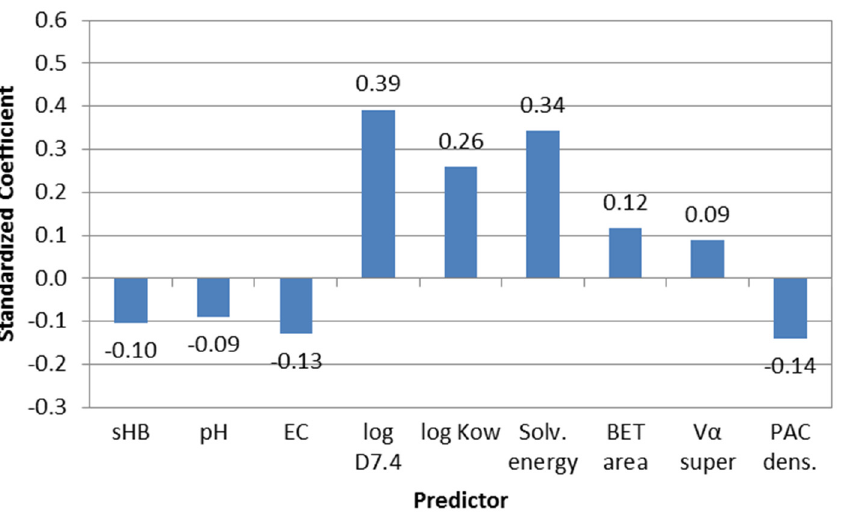
Figure 4. Standardised coefficients of the nine parameters’ model fitting (21 h batch adsorption).